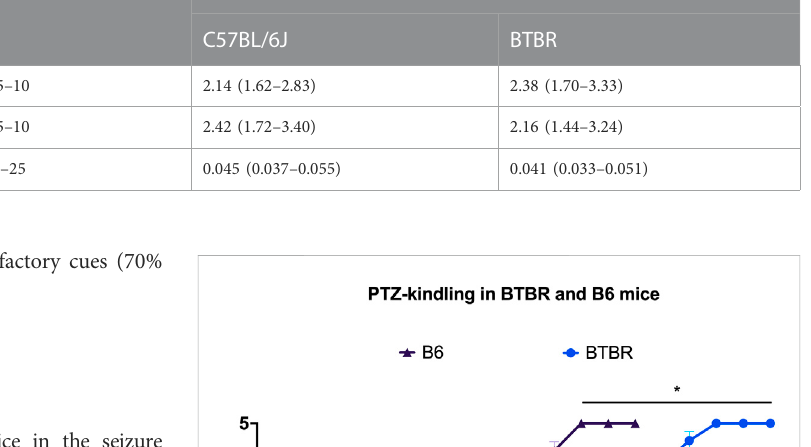
TABLE 2 Seizure susceptibility of C57BL/6J and BTBR mice to convulsant drugs acting on the inotropic glutamatergic receptors. All data reported in the present table are expressed as nmol/mouse except for kainate which is expressed as mg/kg. Mouse strain convulsant